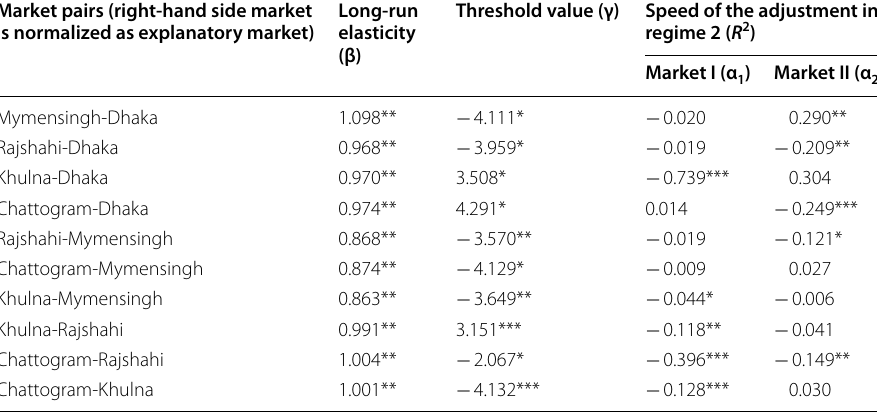
Table 7 Normalized long-run elasticity and speed of adjustment coefficients at threshold vector error correction